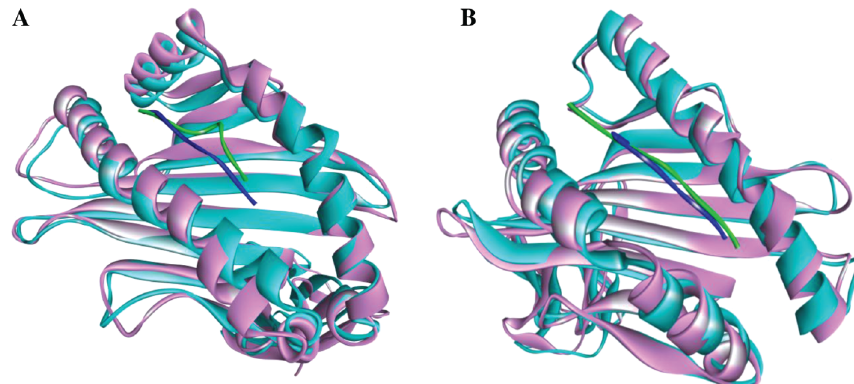
Figure 5: Superimposed images of (A) ALQTGITLV-4PRN and (B) VPSSSTPL-3OX8 complexes before and after 50 ns MD simulation. (Pink- protein before simulation; Cyan- protein after simulation; Blue- peptide before simulation; Green- pep- tide after simulation)